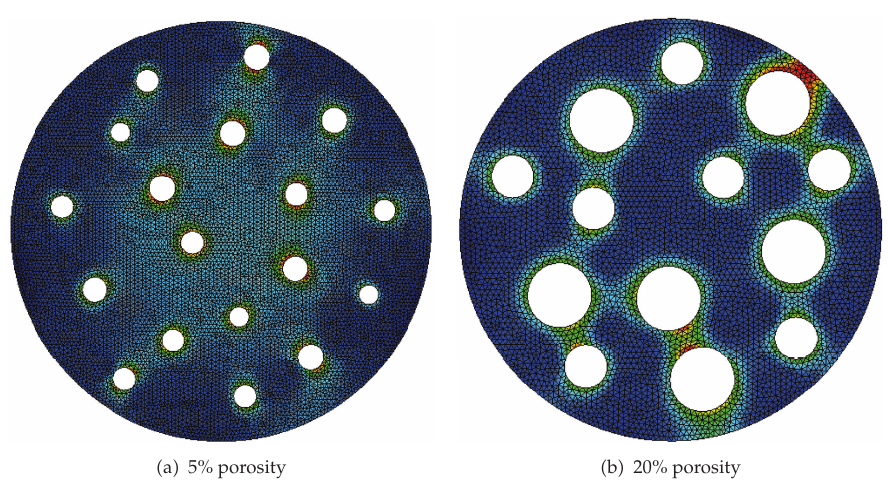
Figure 6: The von-Mises stress distribution in the circular substructure with two di ff erent porosities.